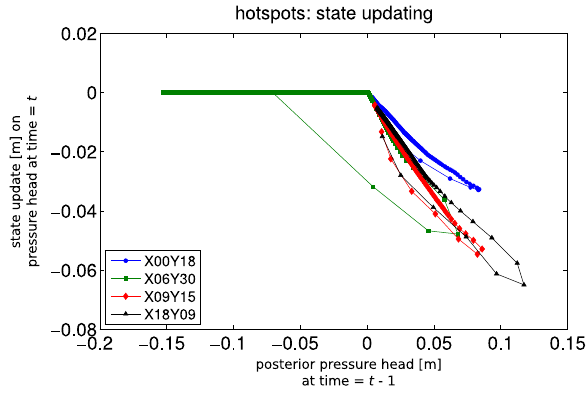
Fig. 8. SODA (idealized data set): state updating as a function of state value for 4 hotspot nodes. The data for this figure originate from SODA’s evaluation of log 10 (r sink ) ≈ − 1 . 97 and log 10 (K s ) ≈ − 0 . 46 .